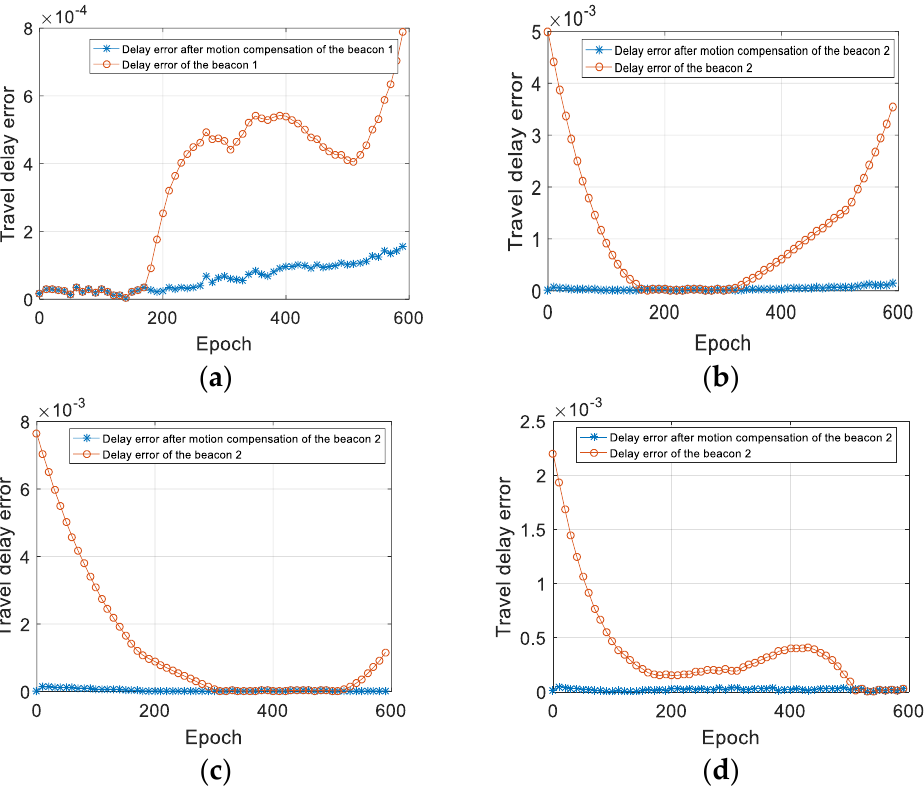
Figure 9. Relative propagation delay after motion compensation.